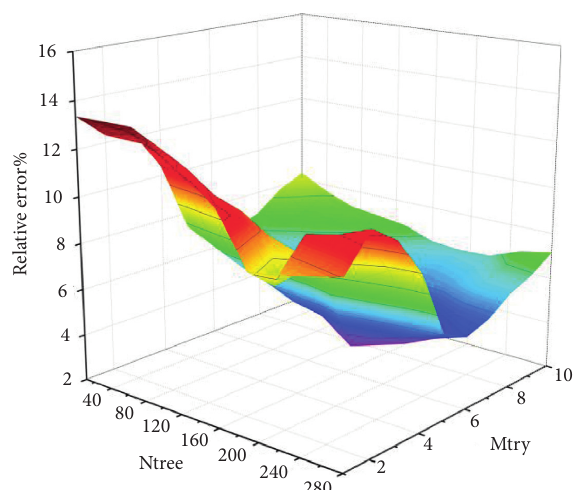
Figure 9: The influence of Mtry and Ntree on relative error.